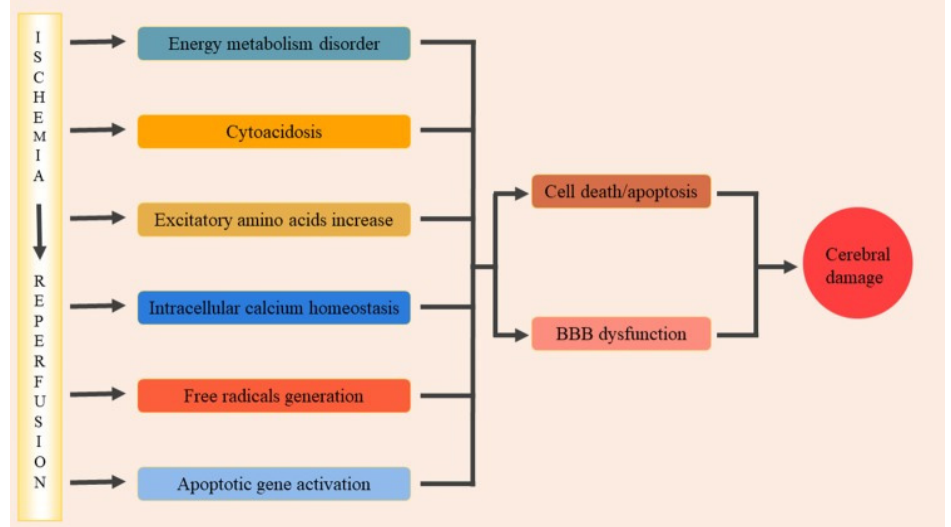
Figure 1. The main pathological processes of brain ischemia and reperfusion [7]. BBB, blood brain barrier. Coped with permission from Front. Mol. Neurosci. 2020, 13, 28. Copyright © 2022 Wu, Xiong, Wu, Ye, Jian, Zhi and Gu.